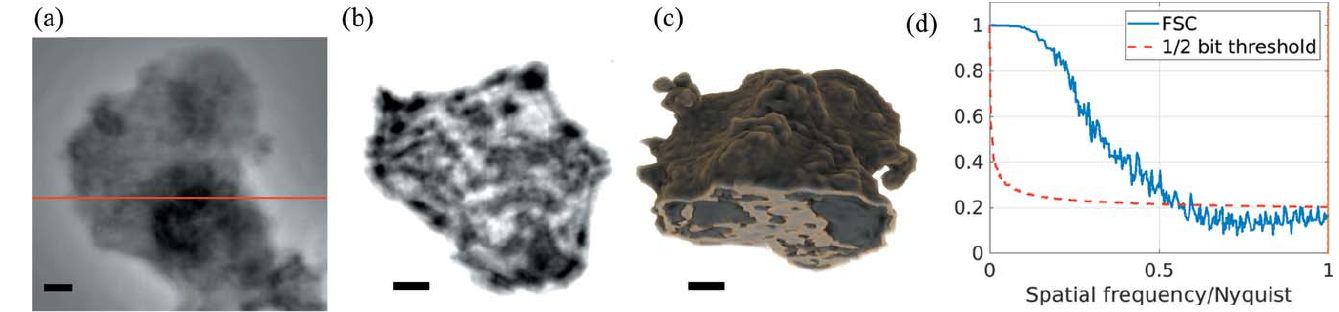
Figure 6 Chalk sample tomographic reconstruction. ( a ) Phase retrieved projection using pure-phase algorithms. ( b ) 3D reconstructed slice marked by the red line in ( a ). ( c ) 3D rendering of the chalk sample. ( d ) Fourier shell correlation results and resolution estimation, where the vertical orange-dashed line represents the focal-spot resolution limit. The scale bars correspond to 2 m m, and the resolution estimated by the half-bit threshold criterion is 155